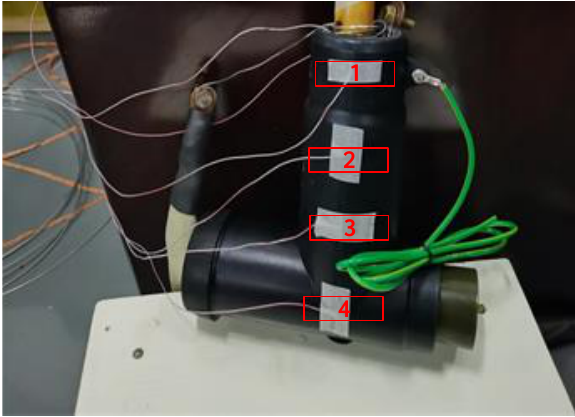
Figure 11. Arrangement of heat source and temperature probes.